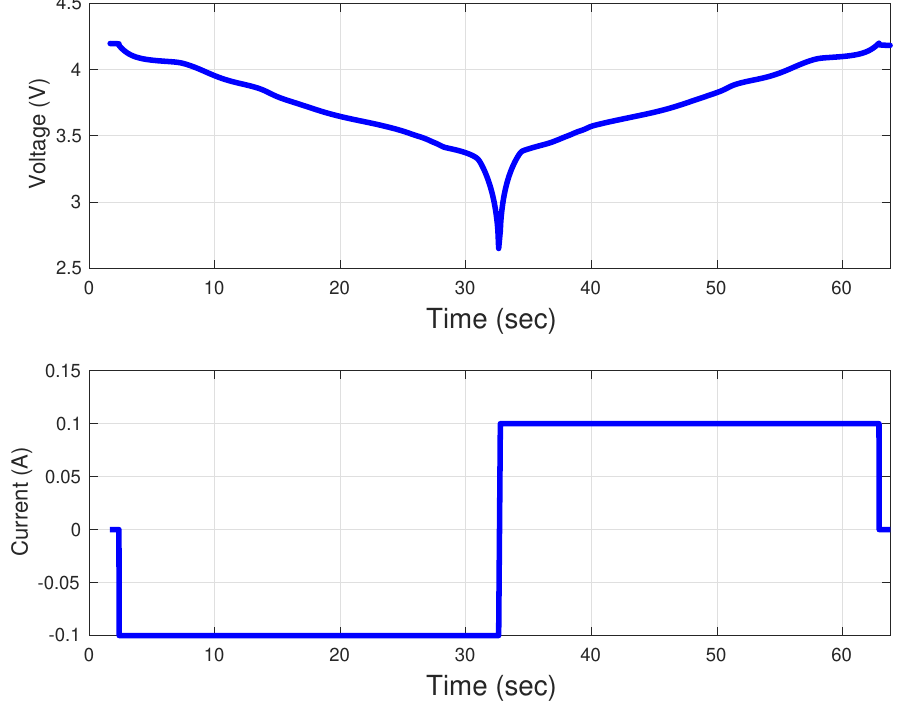
Figure 3. Measured voltage and current during charge and discharge at 25 °C